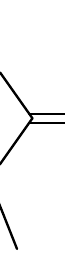
Table 1. Chemical data, source, and purities of the 1-methylhydantoin utilized in this work. CAS Number Source